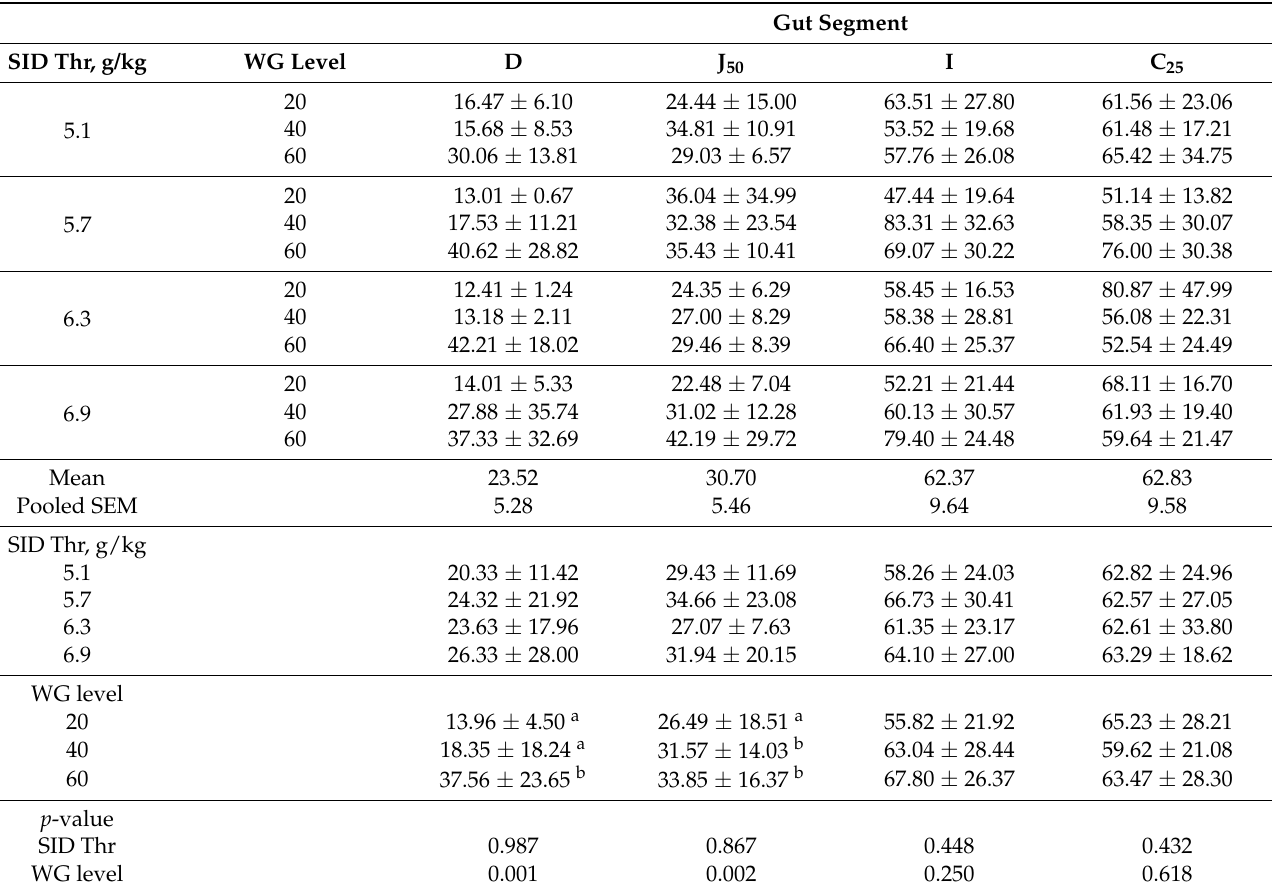
Table 1. Tissue mucin content measured as the total amount of O -linked oligosaccharide chains ( µ g/g tissue) in gut segments of pigs fed diets differing in standardized ileal digestible threonine (SID Thr) content and wheat gluten (WG)